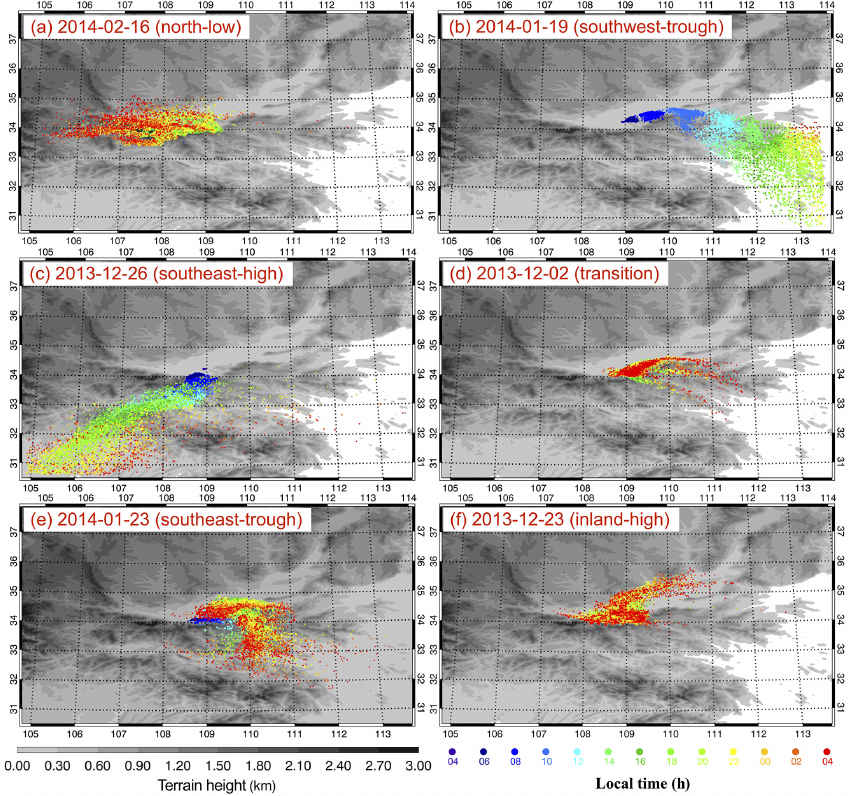
Figure 4. Twenty-four-hour plume transport patterns initialized from 04:00BJT on (a) 16 February 2014 (“north-low”), (b) 19 January 2014 (“southwest-trough”), (c) 26 December 2013 (“southeast-high”), (d) 2 December 2013 (“transition”), (e) 23 January 2014 (“southeast- trough”), and (f) 23 December 2013 (“inland-high”). The gray contour denotes the terrain height. The color dots represent the released particles at different